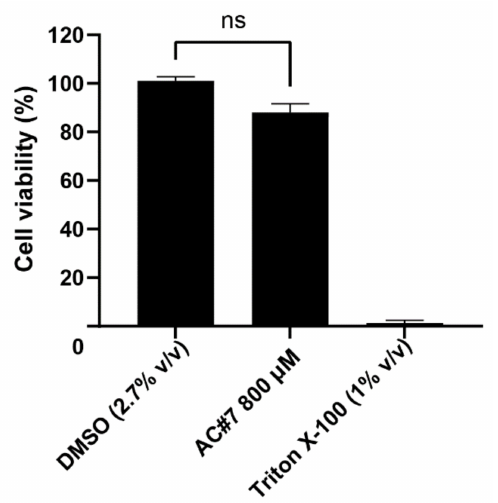
Figure 6. Toxicity of AC#7 in VERO cells at 800 µ M. The cytotoxicity of AC#7 was tested by incubating Vero cells with AC#7 (800 µ M) for 2 h. AC#7 was then removed, and cells were incubated in fresh media for a further 46 h before cell viability was evaluated using water-soluble tetrazolium 1. Cells without any treatment were included as cell-only control and used to calculate cell viability. Cells treated with dimethyl sulfoxide (DMSO) (2.7% v / v ), corresponding to the solvent concentration in the tested samples, were used as the solvent control. The wells treated with 1% ( v / v ) Triton X-100 were used as a negative control. The cytotoxicity assay was performed three times with duplicates. Means of the three experiments are plotted with standard error of the mean. Wilcoxon test was applied to compare the cytotoxicity of DMSO control and AC#7 (ns indicates not significant, p >